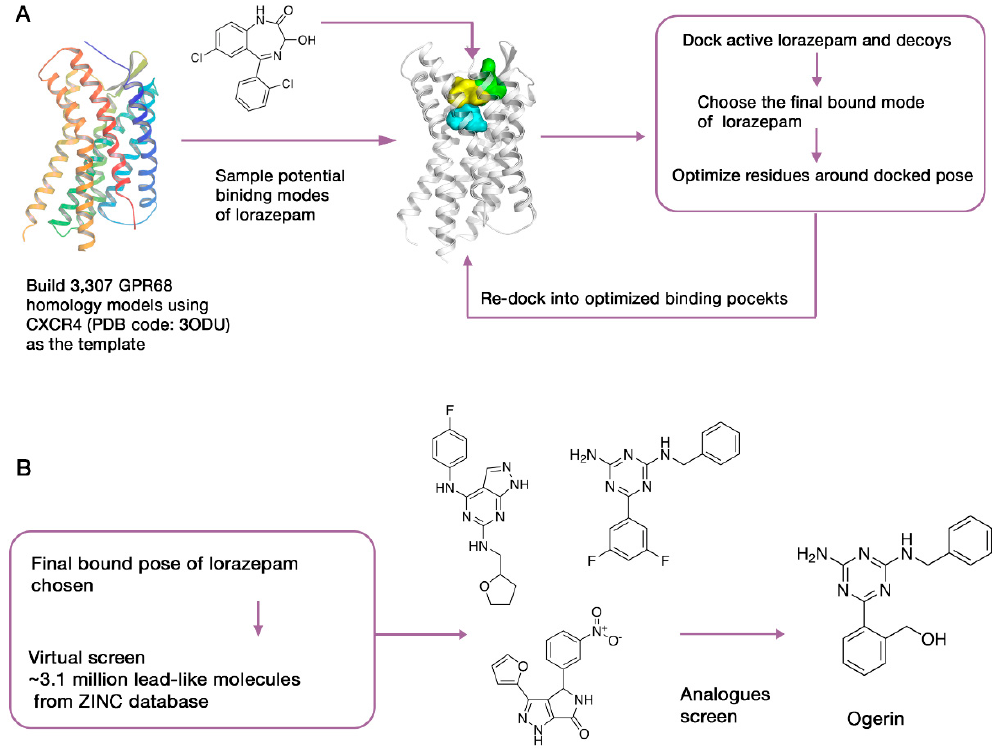
Figure 2. A virtual screening workflow for the discovery of probes targeting GPR68. ( A ) The acquisition of predicted lorazepam–GPR68 binding conformation through several cycles of optimization. ( B ) Virtual screen and analogues screen of ZINC database to identify hits with high affinity and selectivity.